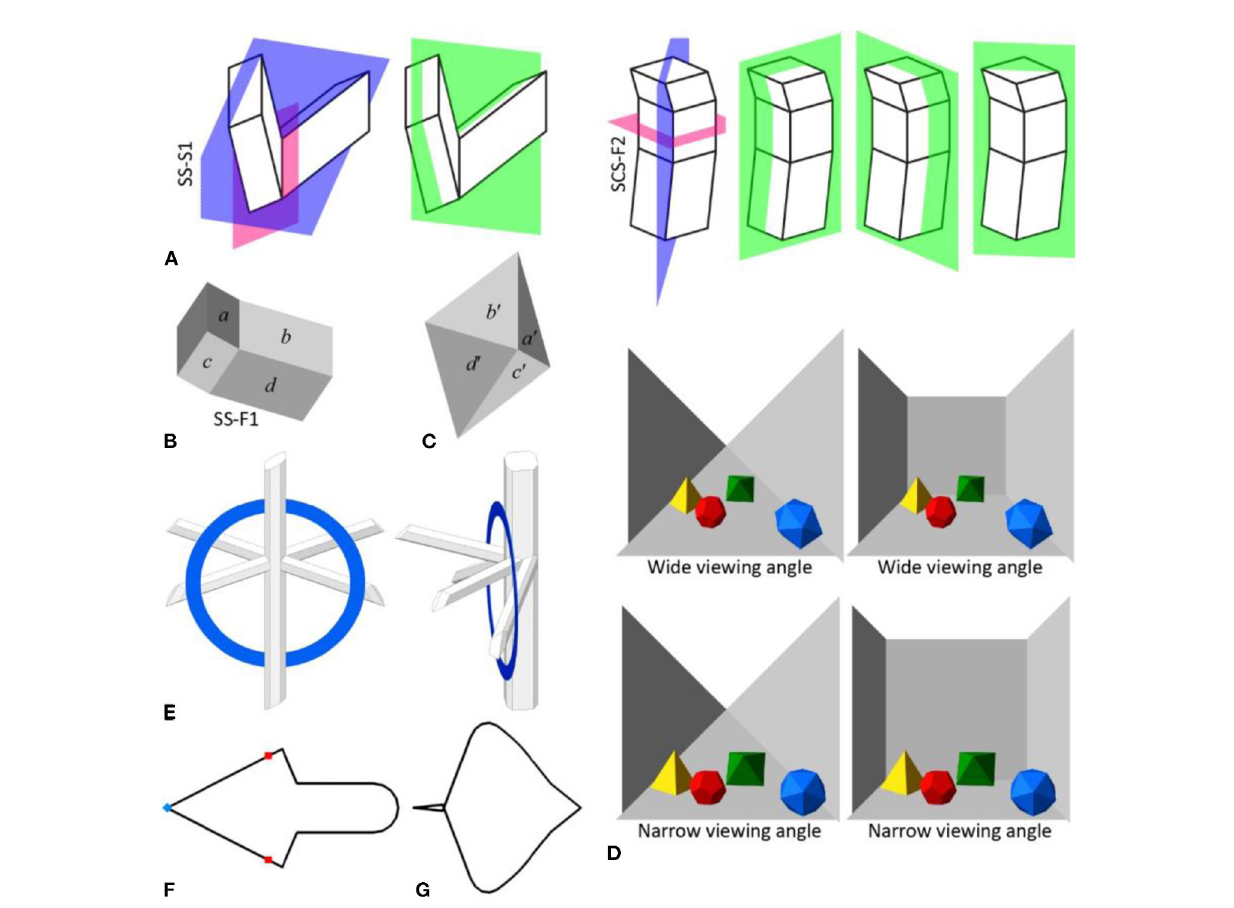
FIGURE1 (A) Two of the visual stimuli used in SP22 (Sugihara and Pinna, 2022, SS-S1 in Figure 4A and SCS-F2 in Figure 6B) and their 3D mirror-symmetrical interpretations. Symmetry planes of their simulated 3D shapes that were considered by SP22 are in pink and those that were not considered are in blue. The symmetry-planes of other 3D mirror-symmetrical interpretations are in green. The additional symmetrical interpretations and their number change depending on the viewing direction of the shading image because of their topological inconsistency against the image (see Sawada and Pizlo, 2008). (B) A shading image of a 3D mirror-symmetrical shape used as a visual stimulus in SP22 (Sugihara and Pinna, 2022, SS-F1 in Figure 4B). Faces a and c are 3D mirror-symmetrical with faces b and d , respectively. Faces b and c are brighter than faces a and d . This pattern of shading cannot be generated with the simulated 3D mirror-symmetrical shape unless the pattern of reflectance is asymmetrical. Note that Lambertian reflectance and a single linear light source are assumed. (C) An image of a cone with a rhombus-shaped base. Faces a ′ , b ′ , c ′ , and d ′ of the cone have the same orientations as faces a , b , c , and d of the simulated 3D shape in (B) . Assuming Lambertian and specular reflections, the faces of the cone would have the same pattern of reflection as the faces of the simulated shape under an orthographic projection. The cone is simply convex and it